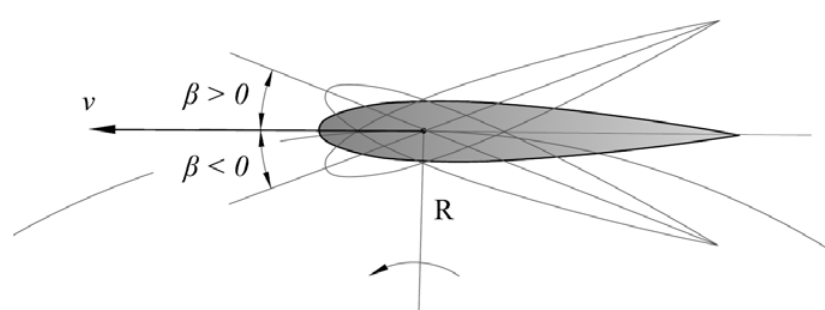
Figure 3. Pitch angle of the rotor’s blade.